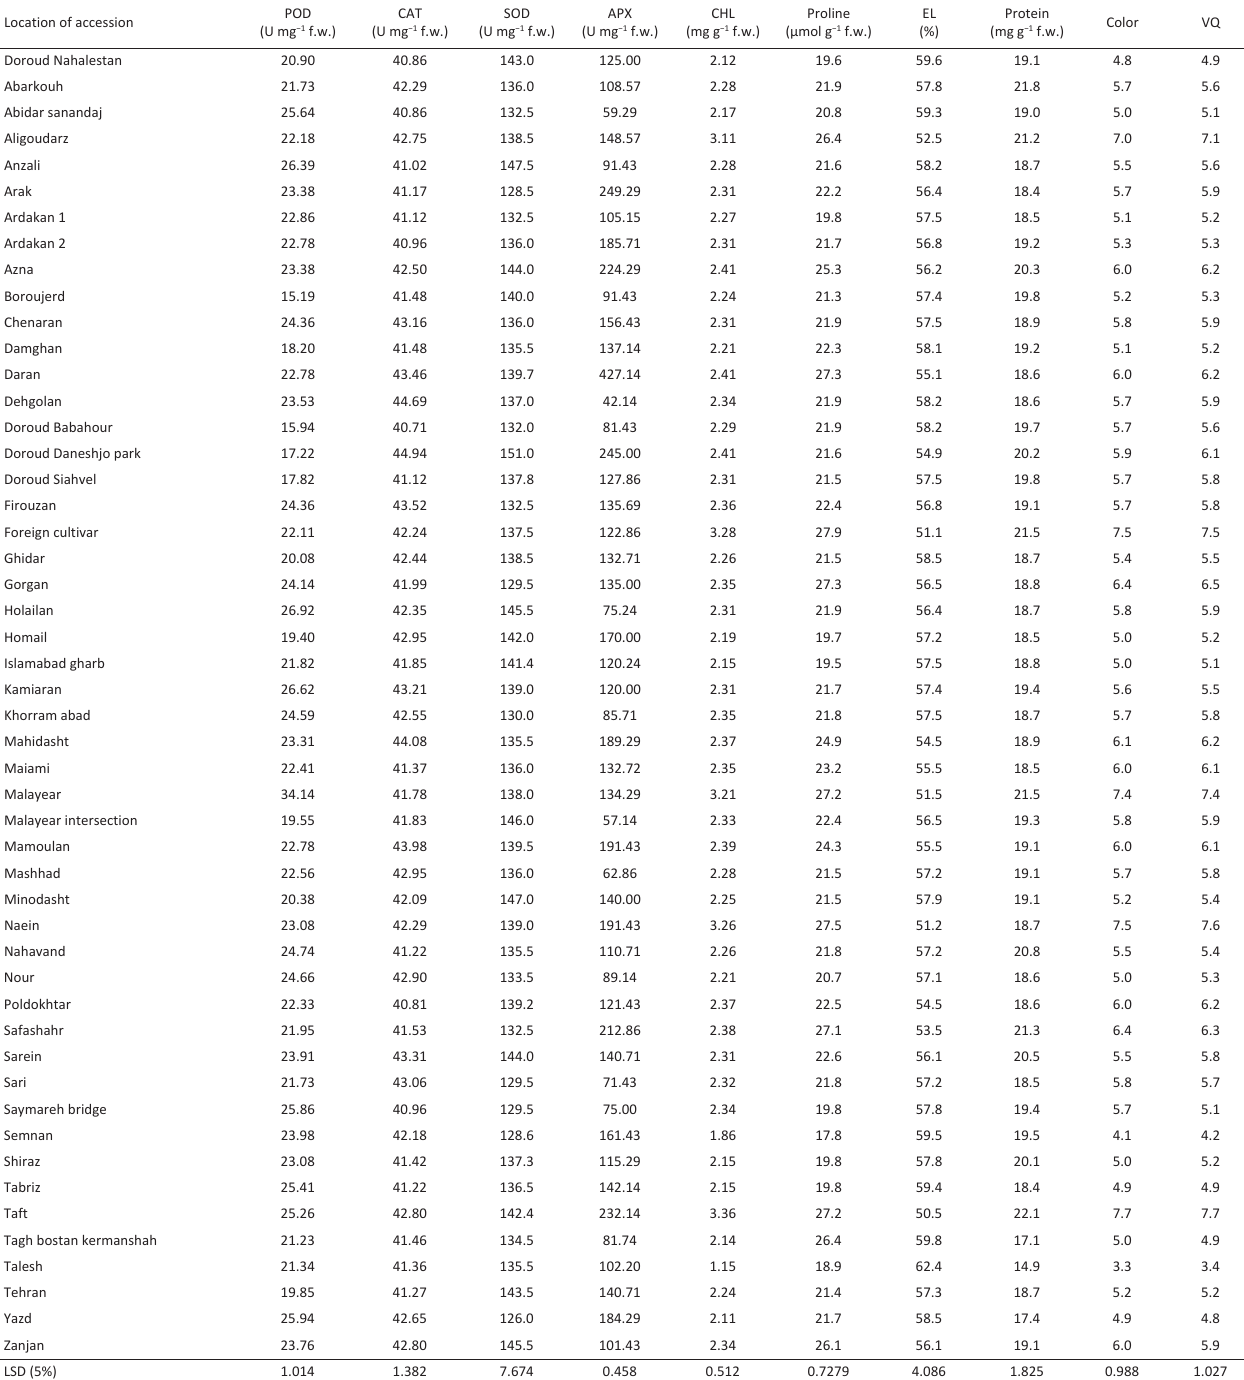
Table 3 - Amount of POD, CAT, SOD, APX, CHL, Proline, EL, protein, color and visual quality of different Iranian accessions and foreign common bermudagrass after cold stress (at -7.5/-12°C day/night cycles) Location of accession POD (U mg −1 f.w.) CAT (U mg −1 f.w.) SOD (U mg −1 f.w.) APX (U mg −1 f.w.) CHL (mg g −1 f.w.) Proline (µmol g −1 f.w.) EL (%) Protein (mg g −1 f.w.) Color VQ